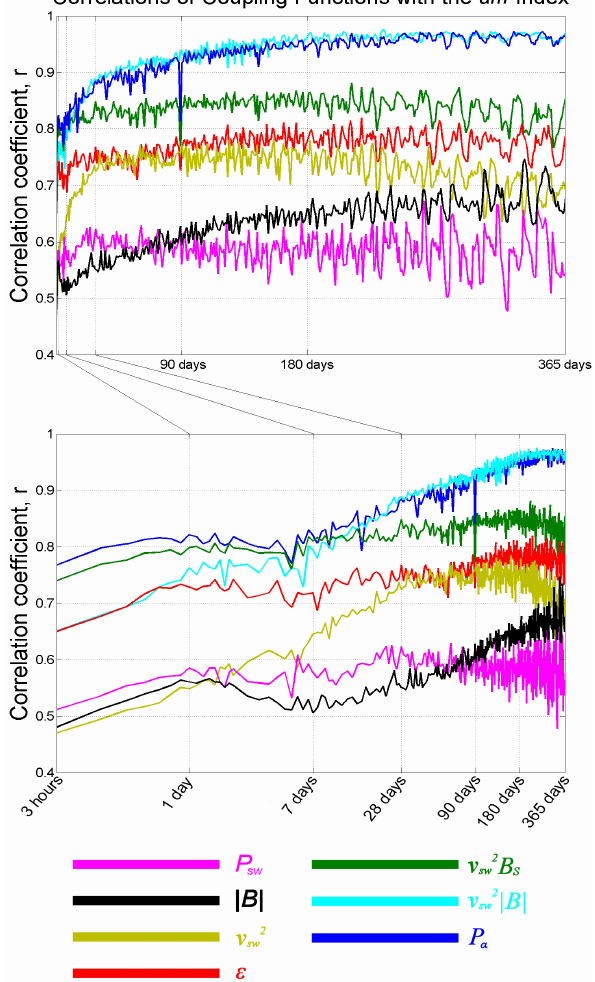
Figure 8. Fig. 8. Correlation between the am index and a number of coupling functions. Upper and lower graphs are identical, other than that the upper graph displays timescale linearly, the lower graph displays it logarithmically. The coloured lines give the results for: dark blue P α , light blue v sw | B | , green v 2 sw B S , red ε , olive v 2 sw , magenta P sw and black | B |